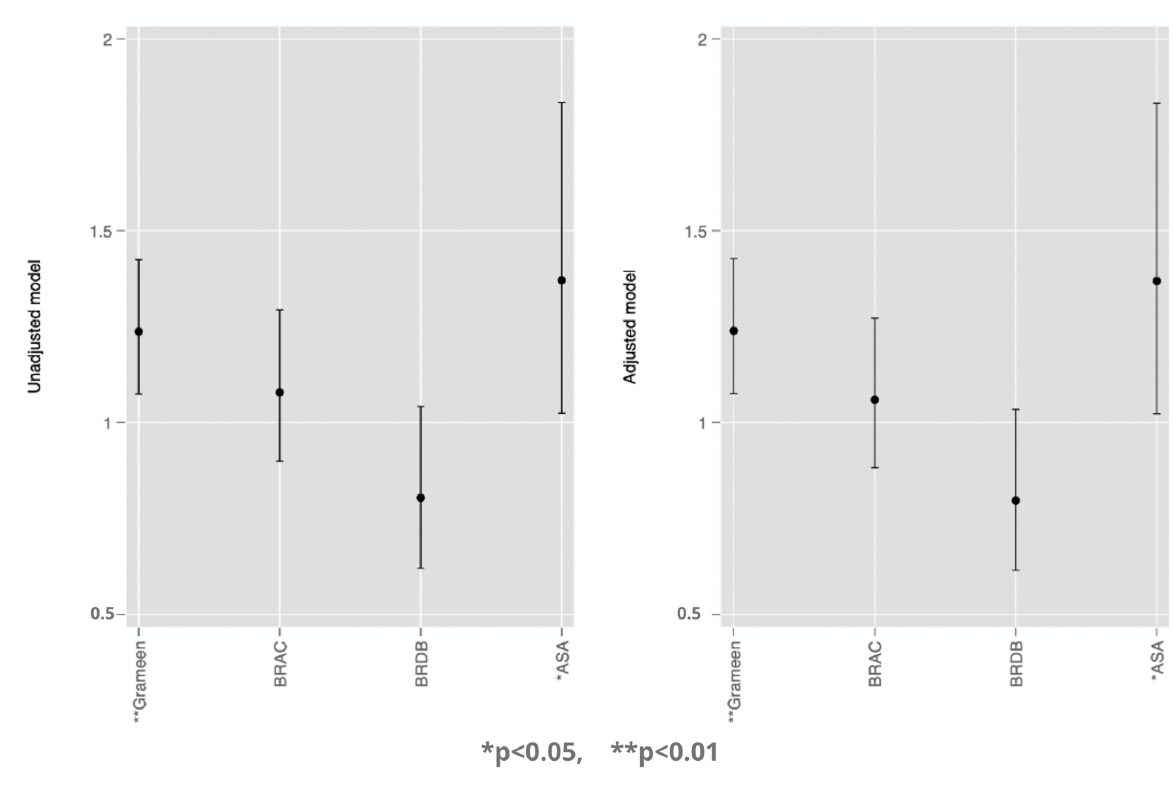
Figure 2. Association between MC membership and health autonomy (BDHS 2004)